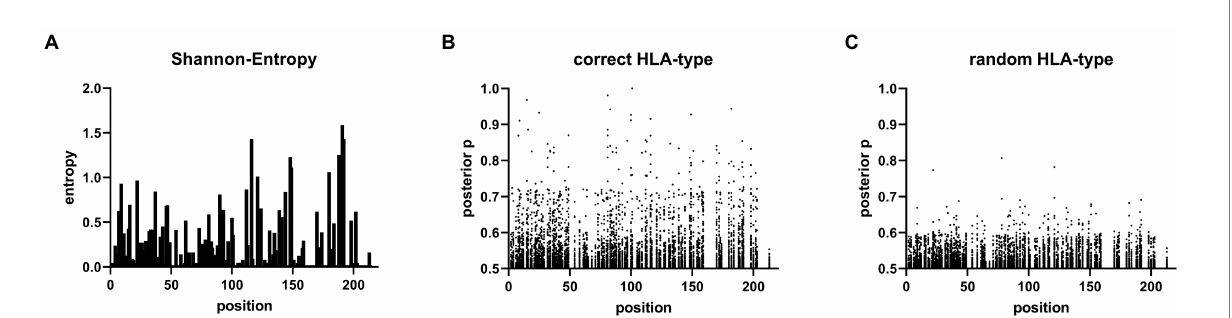
FIGURE 3 Sites under selection predicted by Bayesian regression model. (A) Shannon entropy map of the 131 L-HDAg Sequences. (B) Posterior probability values >0.5 of the Bayesian regression model from the HAMdetector for each HLA-molecule on every amino acid in the L-HDAg are shown. (C) Posterior probability values of an HAMdetector run with the same alignment however with randomly assigned HLA-type.